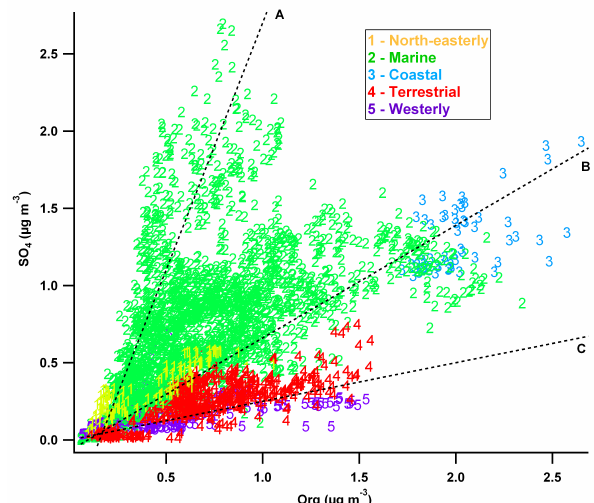
Fig. 16. SO 4 loading vs. OA loading coloured and numbered by cluster. Lines, labelled with letters, indicate different proposed dependencies. Lines represent modes of the SO 4 :org ratio histogram of values.